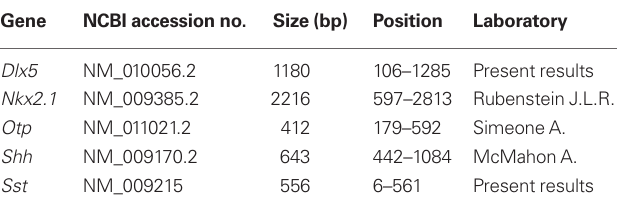
Table 1 | Characteristics of the gene probes used for